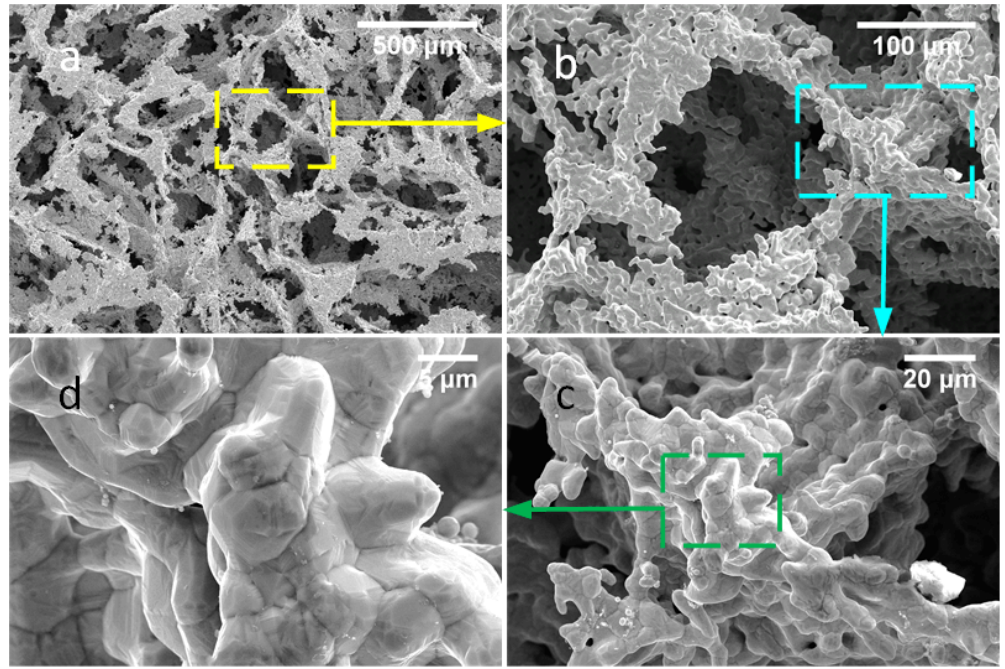
Figure 3. Top surface SEM images of a nondestructive porous copper sample taken at different magnifications: ( a ) 200, ( b ) 1000, ( c ) 3000, and ( d ) 10,000.